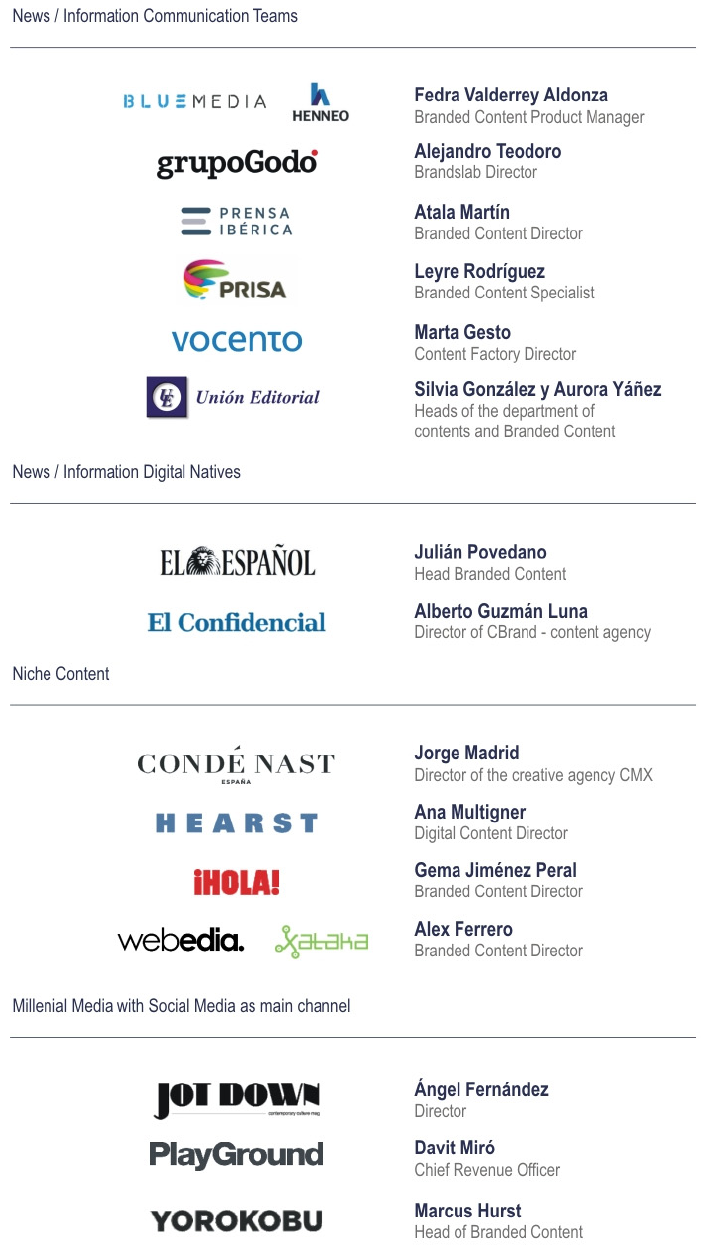
Figure 2. Sample of managers and groups/media interviewed.